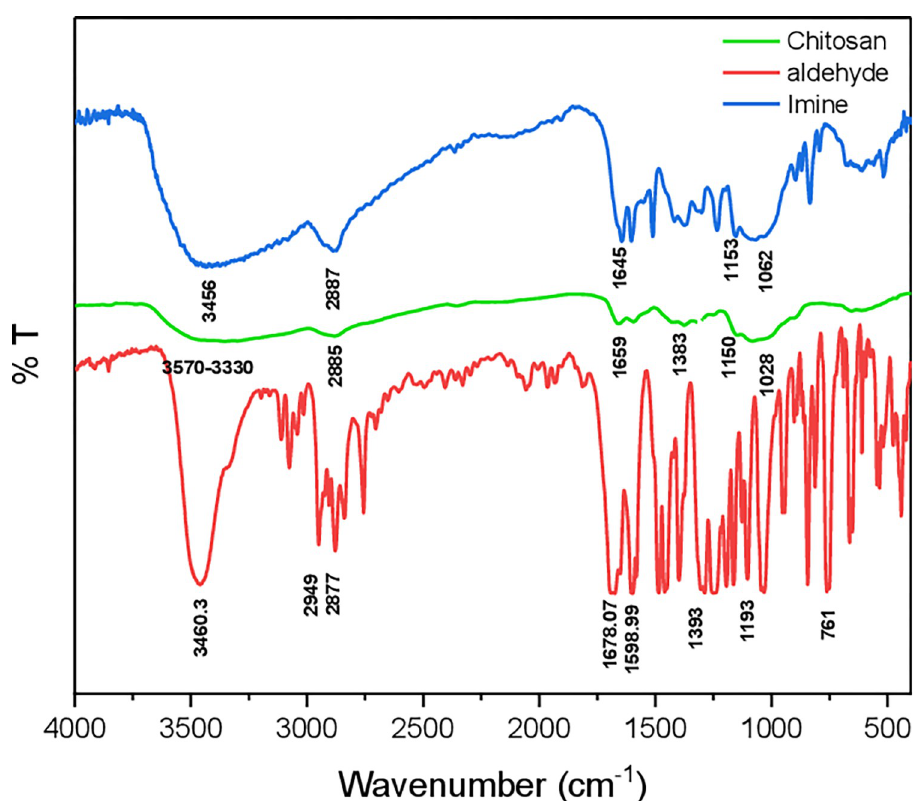
Fig 2. FTIR for Chitosan, Aldehyde (Compound 1), and Imine.